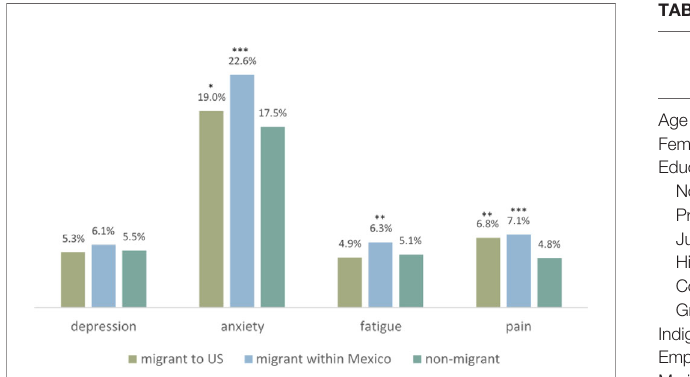
FIGURE 1 | Mental health conditions of U.S. and Mexican Migrants and Non-Migrants. Signi fi cance tests of differences between migrants and non- migrants, * p < 0.10, ** p < 0.05, *** p < 0.01. Source: EDER 2017; ENH 2017.